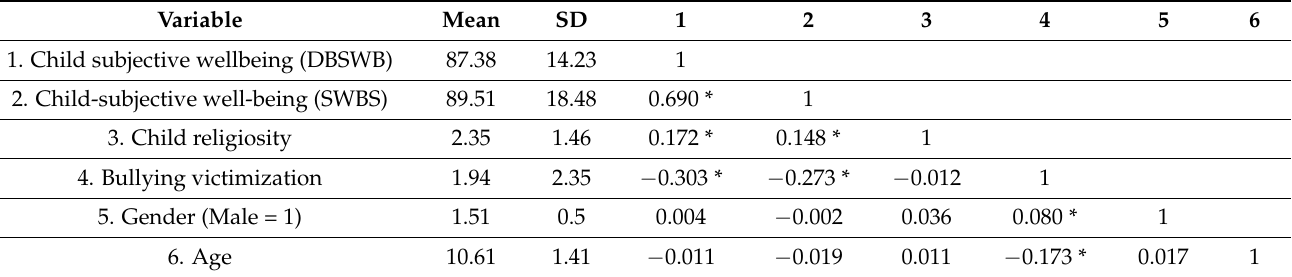
Table 1. Means, standard deviations and Pearson correlations of the study’s variables (N = 2733). Variable